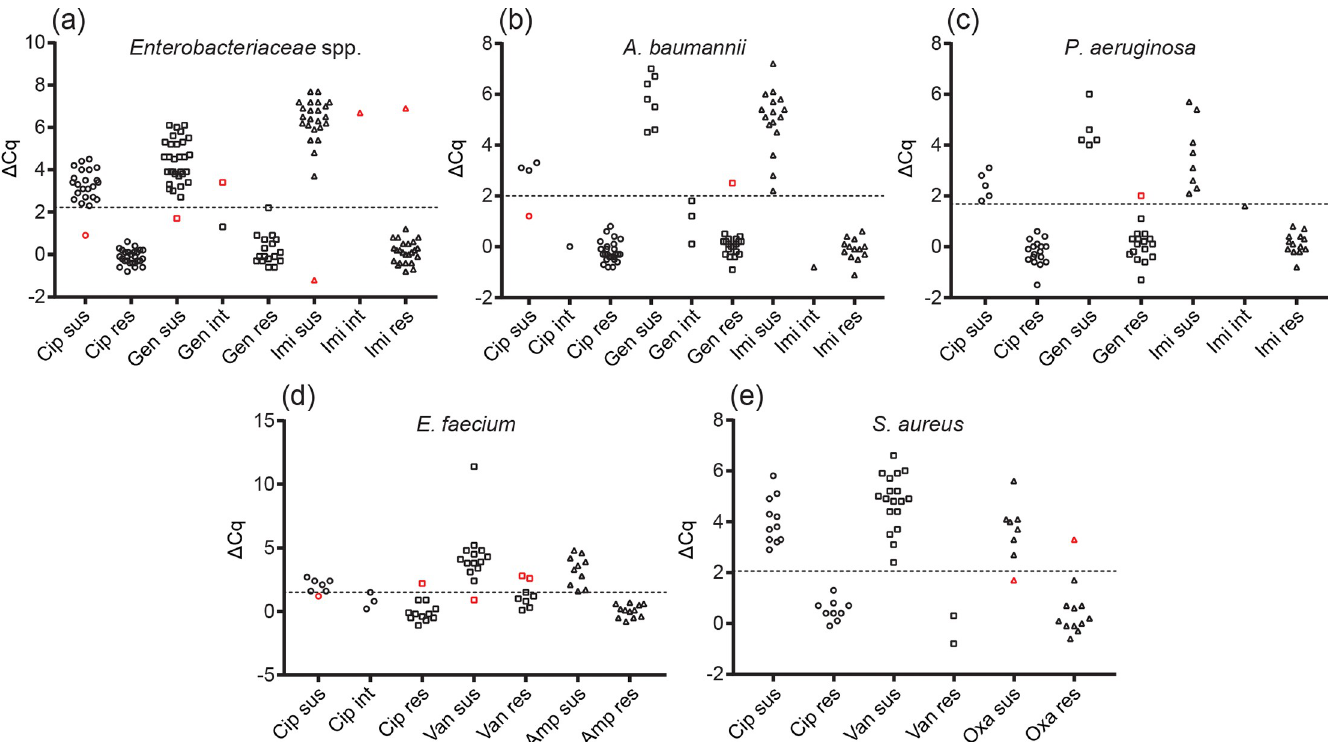
Fig 1. Distribution of Δ Cq values for tested isolates. The Δ Cq values for all isolates are shown, separated by antibiotic and susceptibility as determined by the reference method (BMD), for (a) Enterobacteriaceae spp., (b) A . baumannii , (c) P . aeruginosa , (d) E . faecium , and (e) S . aureus . Isolate-antibiotic combinations that resulted in minor, major, or very major errors are colored red. Sus, susceptible; int, intermediate; res, resistant; Cip, ciprofloxacin; Gen, gentamicin; Imi, imipenem; Van, vancomycin; Amp, ampicillin; Oxa, oxacillin.